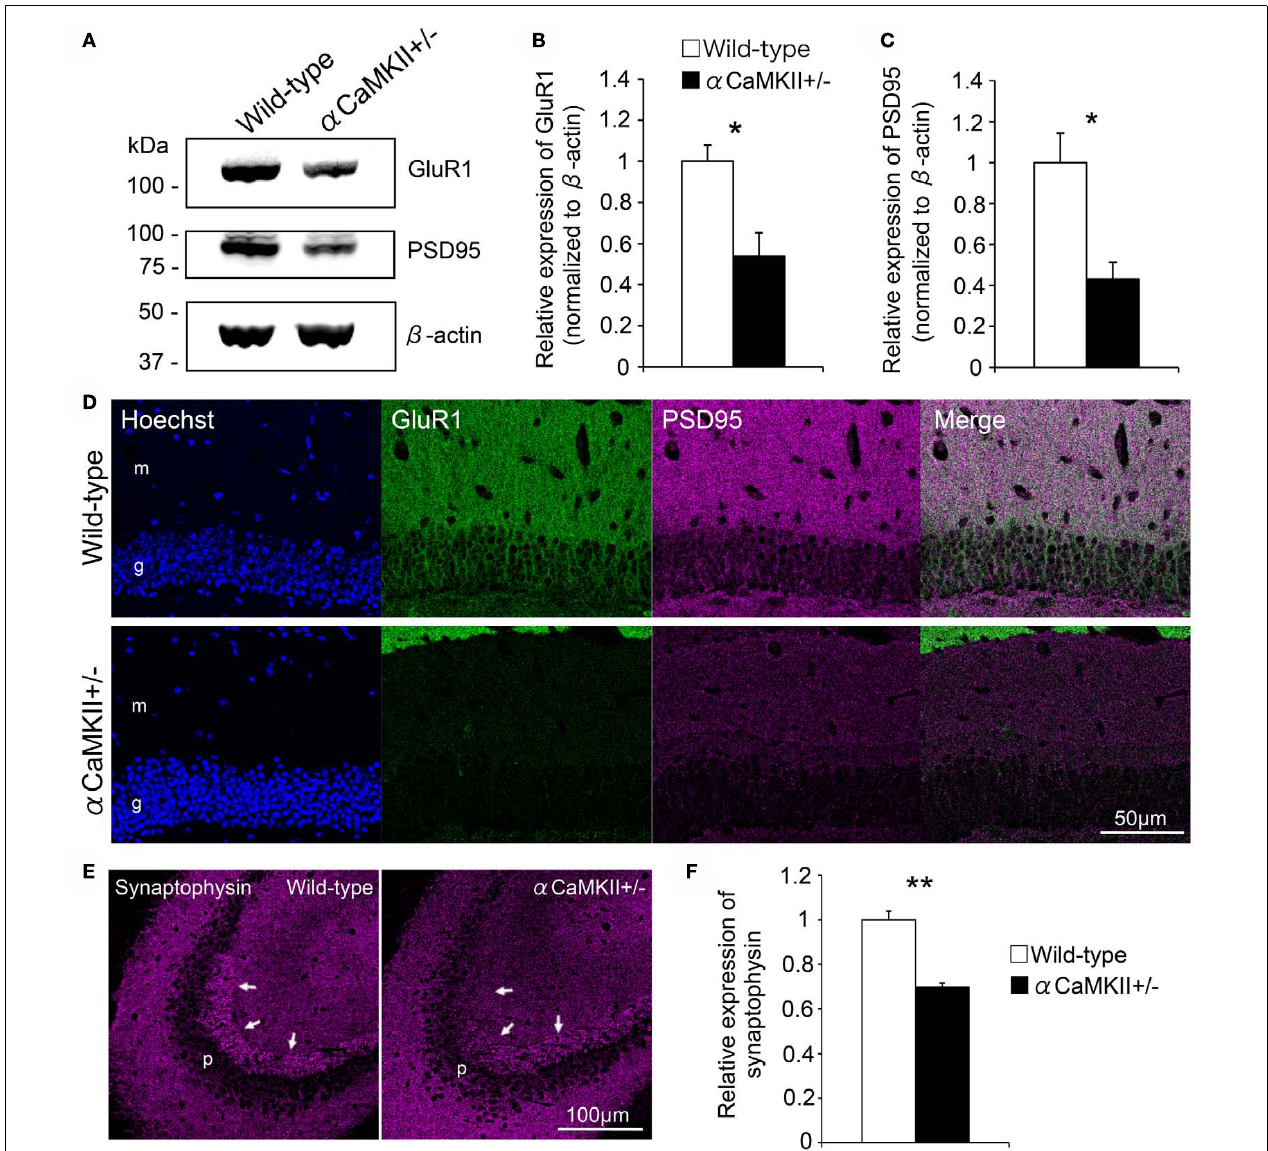
differences: * p < 0.05 (Student’s t -test). (D) Immunostaining revealed that the expression of a postsynaptic marker, PSD95, was downregulated in both the granule cell and molecular layers of the mutants. (E,F) In the mutants, expression of a presynaptic marker, synaptophysin, was also decreased in mossy fiber terminals within the stratum lucidum of CA3 [arrows in (E) ]. Synaptophysin immunoreactivity in CA3 was quantified (F) . Values represent fluorescent intensity as a ratio of α CaMKII ± mice to wild-type mice and are given as the mean ± SEM of the analysis based on the results of three mice. Asterisks indicate statistically significant differences: ** p < 0.01 (Student’s t -test). g, Granule cell layer; h, hilus; m, molecular layer; p, pyramidal cell